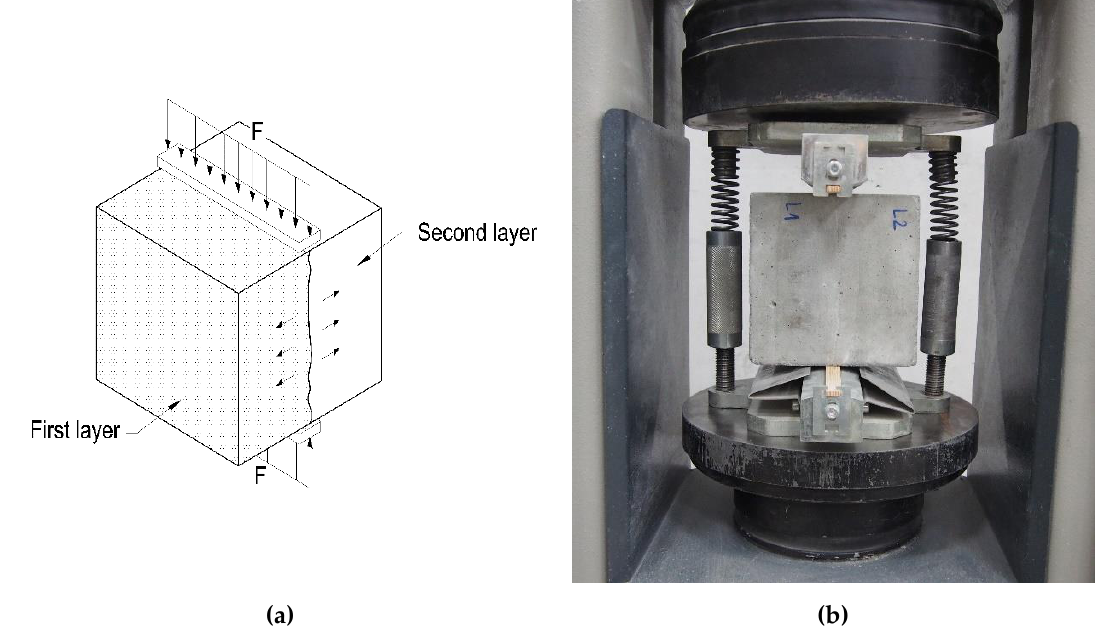
Figure 3. A view of ( a ) the test setup schematic and ( b ) a typical sample for bond strength tests on Standard Automatic compression tester, Controls, Compact-Line.